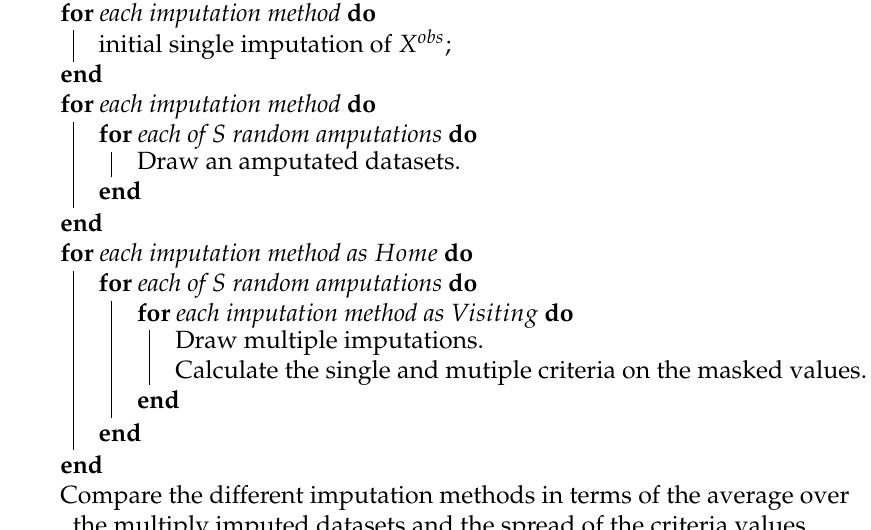
Algorithm A1: Algorithm for evaluating the performance of imputation meth- ods in real-world